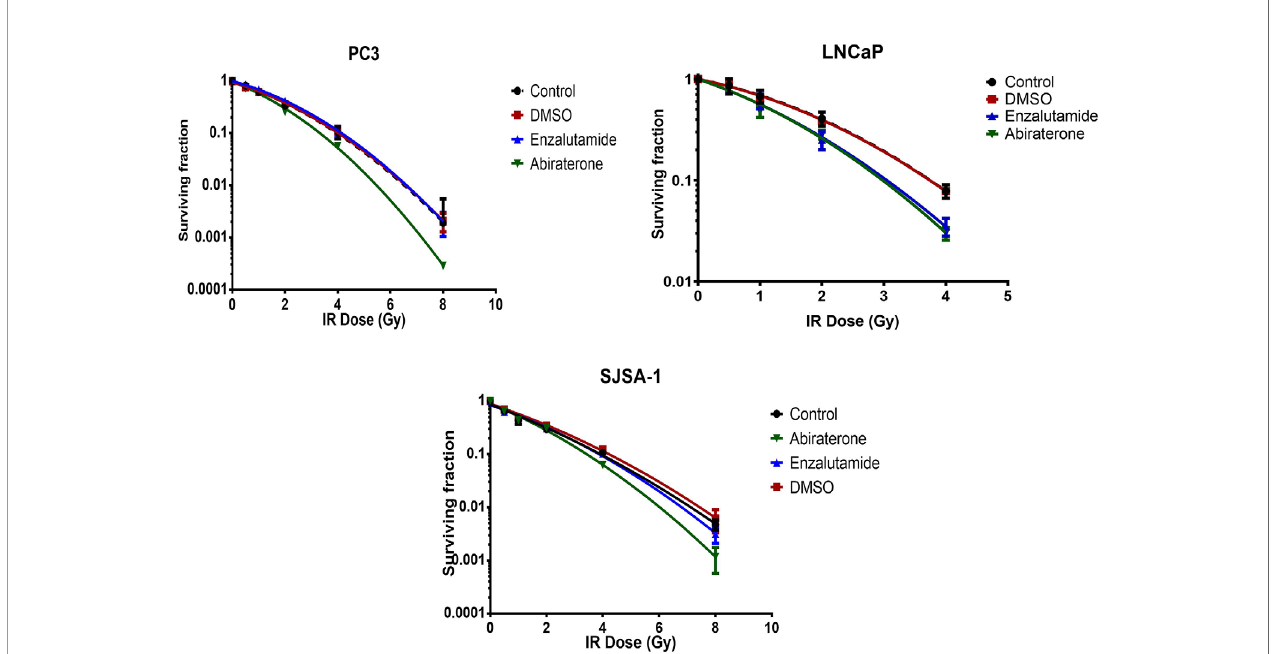
FIGURE 4 | Radiosensitization effects of Abiraterone, Enzalutamide and DMSO on radiation in androgen-insensitive PC3 prostate cancer model, androgen-sensitive LNCaP model and osteoblastic bone model SJSA-1 by colony formation assay. LNCaPs were treated with 200 nM, while PC3s and SJSA-1s were treated with 10 m M Abiraterone, Enzalutamide or DMSO 24 hours before X-Ray across a dose range of 0-8 Gy. Cells were then left to form appropriately sized colonies and survival fraction calculated using SF = (colonies counted) / (cells seeded x (PE/100) colonies counted). Error bars are standard error of the mean (+/- SEM) and for some points, the error bars are shorter than the height of the symbol (n=3).